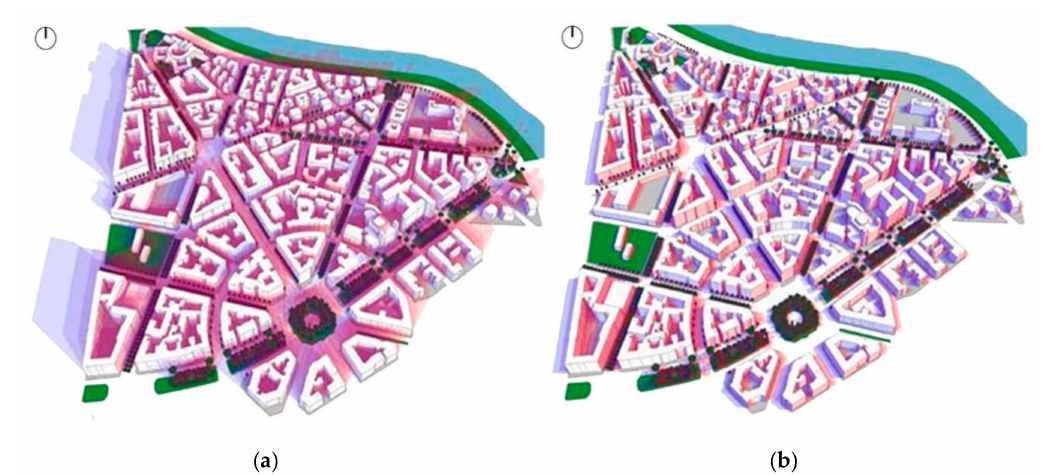
Figure 2. Prati area shadow factor: ( a ) Winter shading analysis based on 21 December, with analysis range 9–12 (blue) 12–15 (red) hours and step 120 min; ( b ) Summer shading analysis based on 21 June, with analysis range 9–12 (blue) 12–15 (red) hours and step 120 min (analysis software: ECOTECT ANALYSIS 2010, software preset grid cell